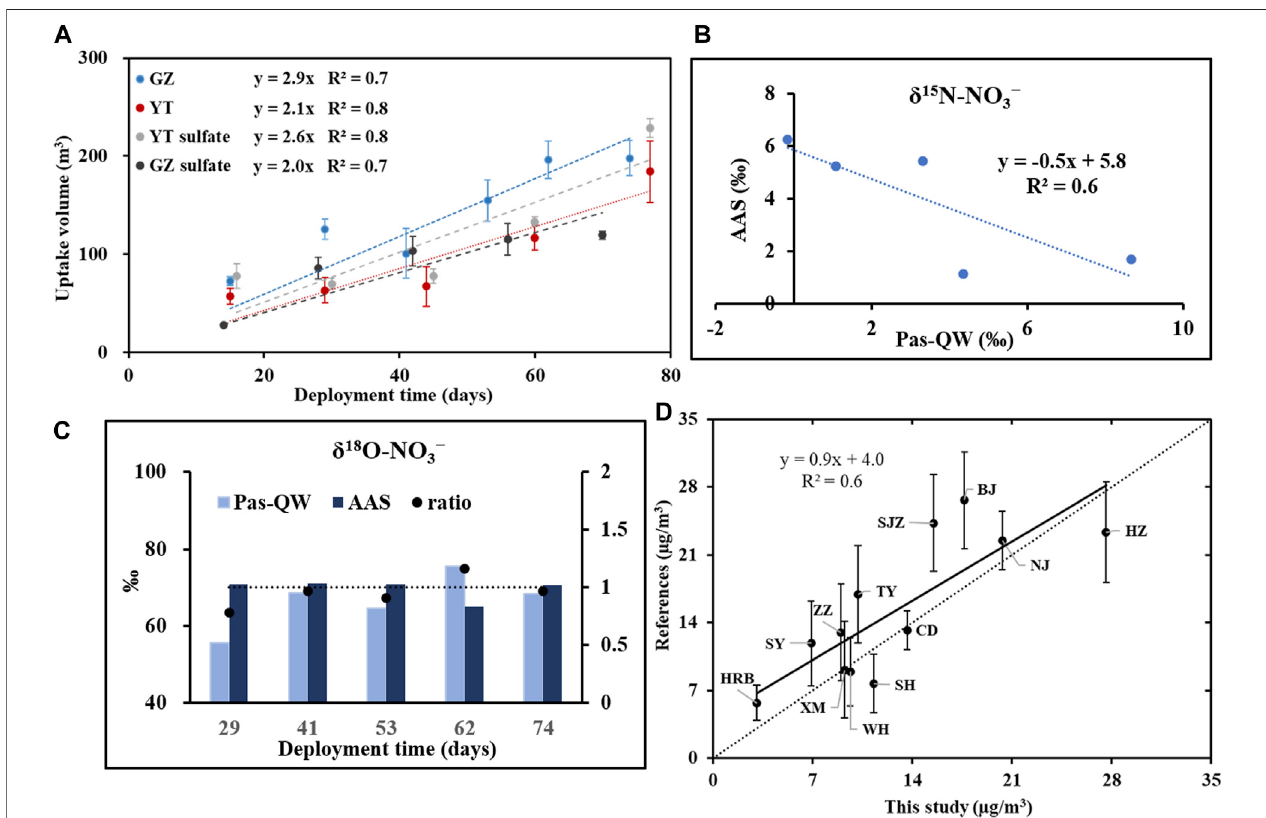
FIGURE 1 | During the calibration exercise, (A) equivalent air volumes for nitrate and sulfate using Pas-QW in Yantai and Guangzhou fi eld sites, (B) comparison of − valuescollectedbyPas-QWandtheAASforGZ, (C) comparisonof δ 18 O-NO δ 15 N-NO 3 in the literatures and this study at twelve